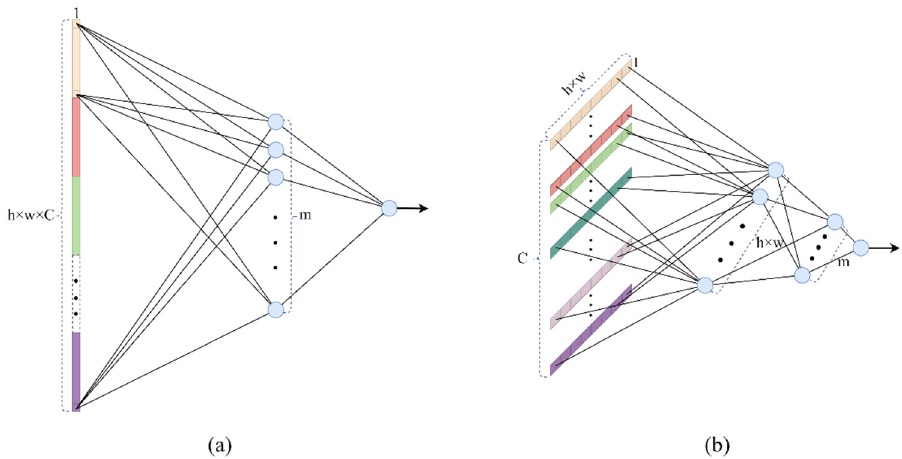
Figure 6. ( a ) Traditional classification layer; ( b ) Weighted classification